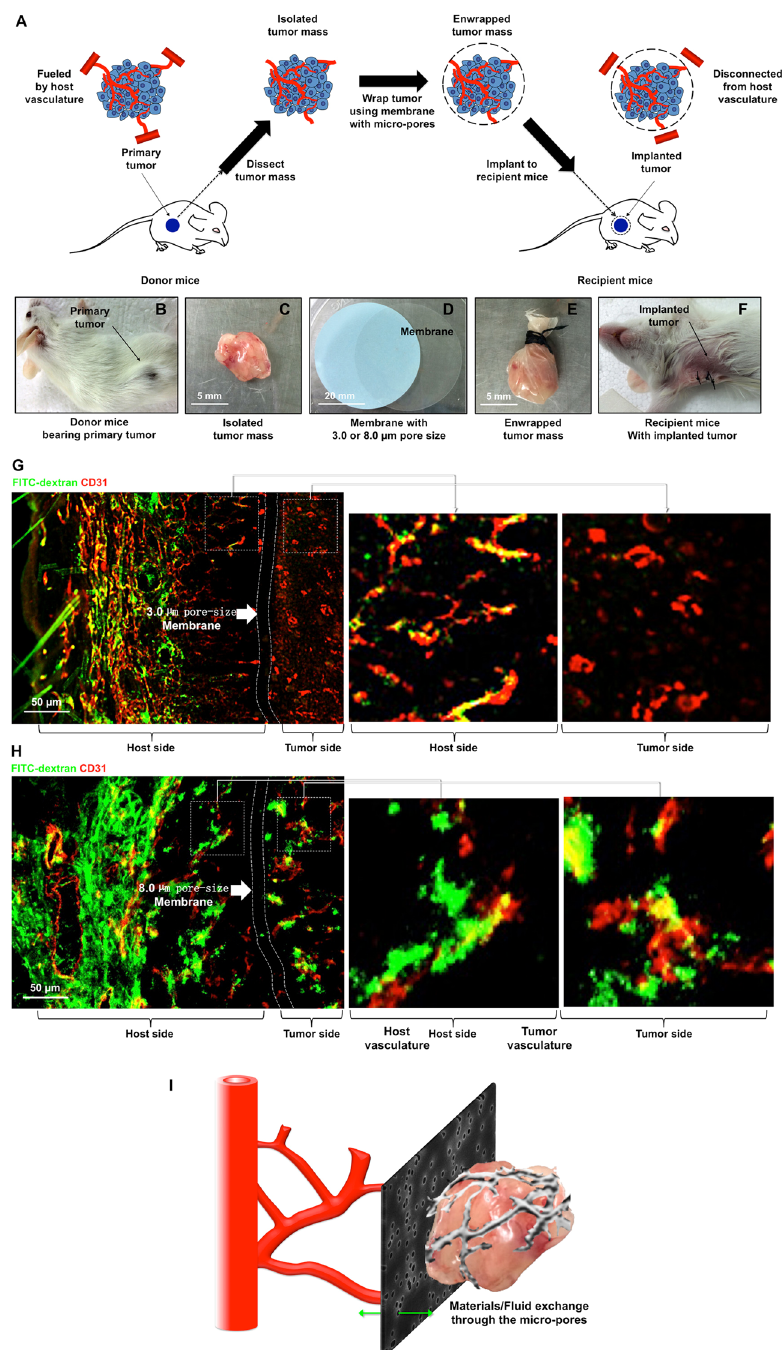
Figure 1. Cutting off tumor blood supply by disconnecting the vasculature between tumor and host using a physical barrier. ( A ) The schematic shows the experimental procedure. To establish the primary tumor, 2.5 × 10 6 4T1 cells were injected into a Balb/c mouse ( B ). When the tumor reached a diameter of approximately 5 mm, it was surgically removed (C) and wrapped with a hydrophilic polycarbonate membrane with 3.0 μ m micro-pores (upper panel: electron microscopy image of the surface of the membrane) (D) . The membrane- wrapped tumor mass ( E ) was then implanted into another healthy recipient mouse (F) . ( G,H ) Three weeks after tumor implantation, FITC-conjugated dextran (2000 kD, green) was injected into the mice through the left ventricle and allowed to circulate for 10 min. The 3.0 μ m ( G ) or 8.0 μ m ( H ) membrane-wrapped tumors were then removed completely, including the adjacent tissues, and stained with CD31 (red) to visualize the entire vasculature. As shown in the right panels, the tissues in the host side were well perfused, but green/red co-localization was not observed on the tumor side of the barrier. ( I ) Under this condition, the tumor and host vasculature was completely disconnected by the physical barrier; on the other hand, the molecules and fluids can cross the border between the host and tumor through the